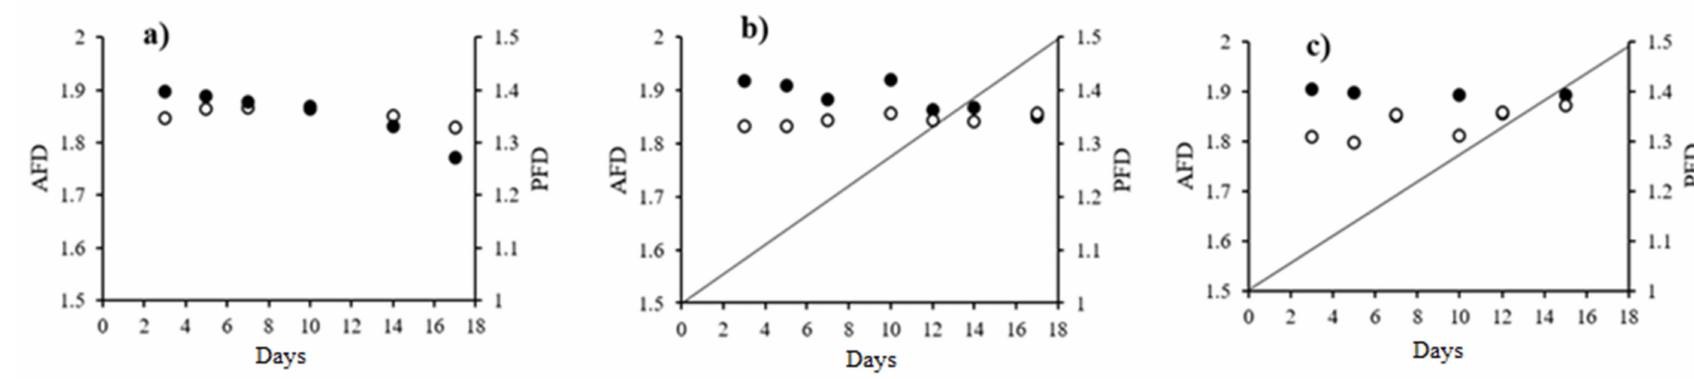
Figure 4. Representation of the perimeter fractal dimension (PFD) ( ) and area (AFD) ( • ) of the treatment groups. Negative control panel ( a ), to AFD y = − 0.0073(x) + 1.91 and PFD (cid:35) y = 0.00002(x) + 1.35. Positive control panel ( b ), to AFD y = − 0.004(x) + 1.91 and PFD y = 0.001(x) + 1.32. Experimental treatment panel ( c ), to AFD y = − 0.003(x) + 1.88 and PFD y = 0.004(x) + 1.275. The value of 2 indicates the area fractal dimension (AFD) and the value 1 is the limit for the perimeter fractal dimension (PFD) (n =